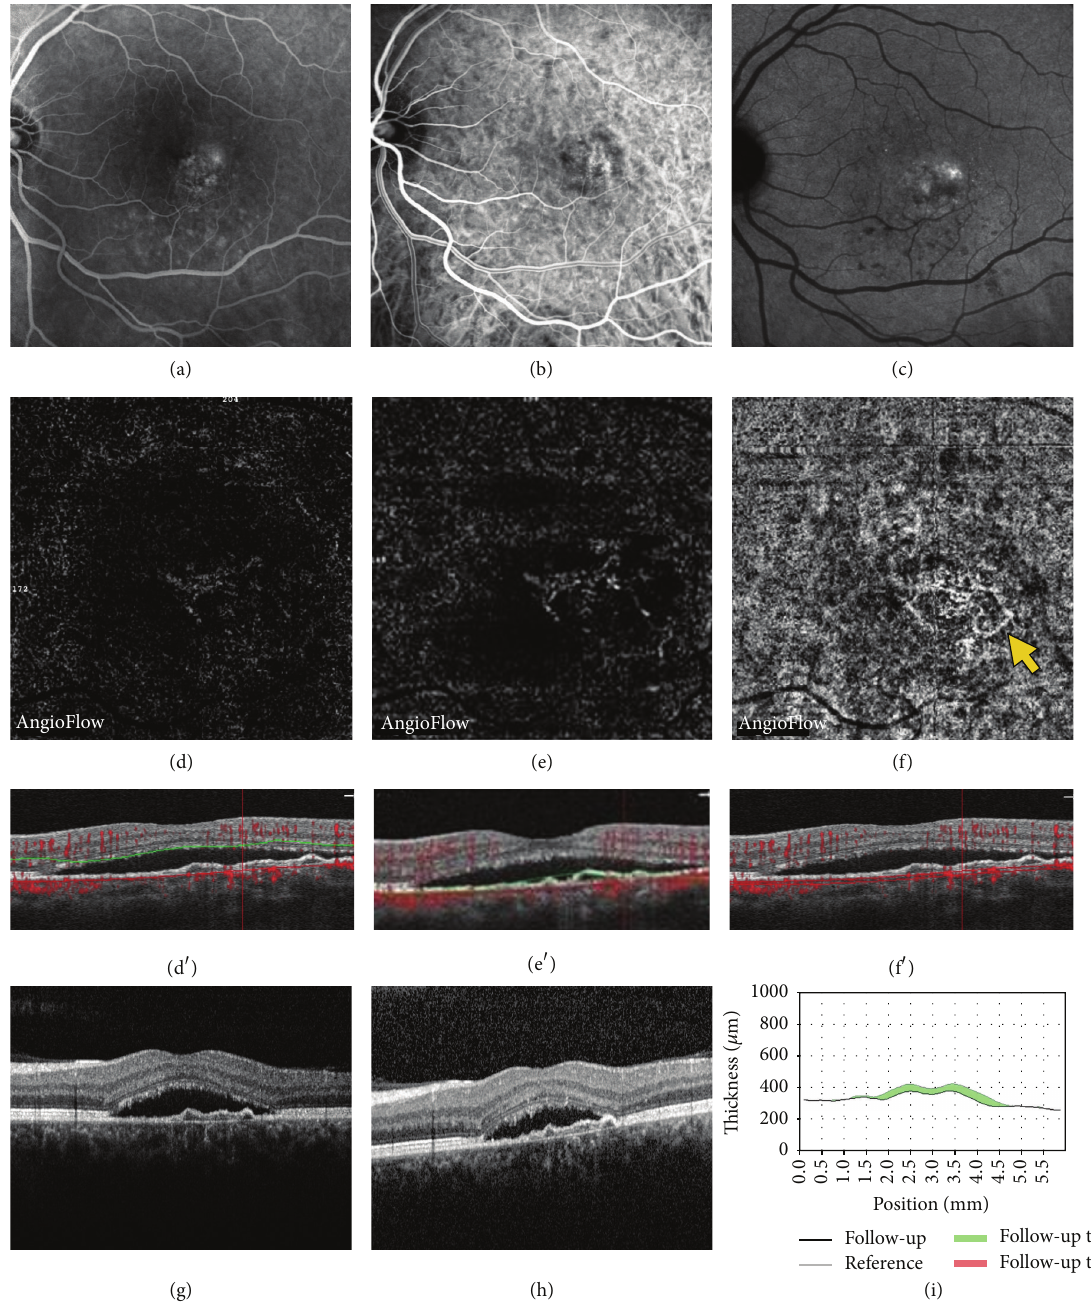
Figure 5: Central serous chorioretinopathy in a 52-year-old man with abnormal choroidal vessels on OCTA, but no evidence of CNV on multimodal imaging. Late phase of fluorescein angiography (FA (a)), early and late phase of indocyanine green angiography (ICGA (b) and (c)), OCTA (d, e, f), and coregistered OCT B-scan (d 󸀠 , e 󸀠 , f 󸀠 ). Late phase of ICG revealed faint hyperfluorescent points, which are usual features of CSR [13] but no clear evidence of neovascular choroidal membrane. Automatically segmented outer retina OCTA image did not show any evidence of hyperdense abnormal signal (d). Manually segmented outer retina OCTA image showing a moderate abnormal hyperdense signal (e). Automatically segmented choriocapillaris OCTA image showing an abnormal choroidal vessel (arrow) with a tangled pattern lesion. OCT revealed mild flat irregular PED and SRD (d 󸀠 , e 󸀠 , f 󸀠 , g). This patient was not treated. After one-month follow-up, the SRD spontaneously decreased (38 microns), arguing in favor of absence of neovascular lesion (h,